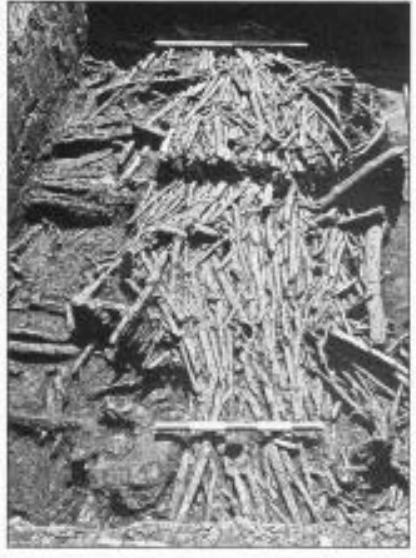
Figure 1 Remains of a Middle Bronze Age trackway found at Beckton, between West Ham and Barking in northeast Lon­ don; it was built on peat and consisted of a V-shape wooden cradle filled with bun­ dles of alder